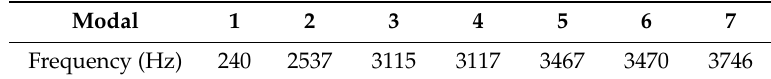
Table 3. The first 7th modes of the hair